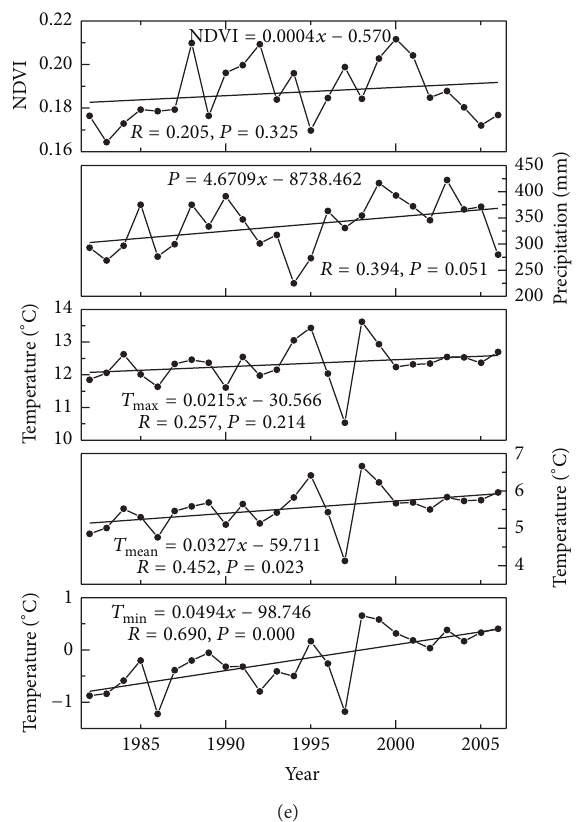
Figure 2: The changes in mean growing season NDVI, precipitation, and temperature ( 𝑇 mean , 𝑇 max , and 𝑇 min ) during 1982–2006 for (a) temperate meadow, (b) temperate steppe, (c) temperate desert steppe, (d) alpine meadow, and (e) alpine